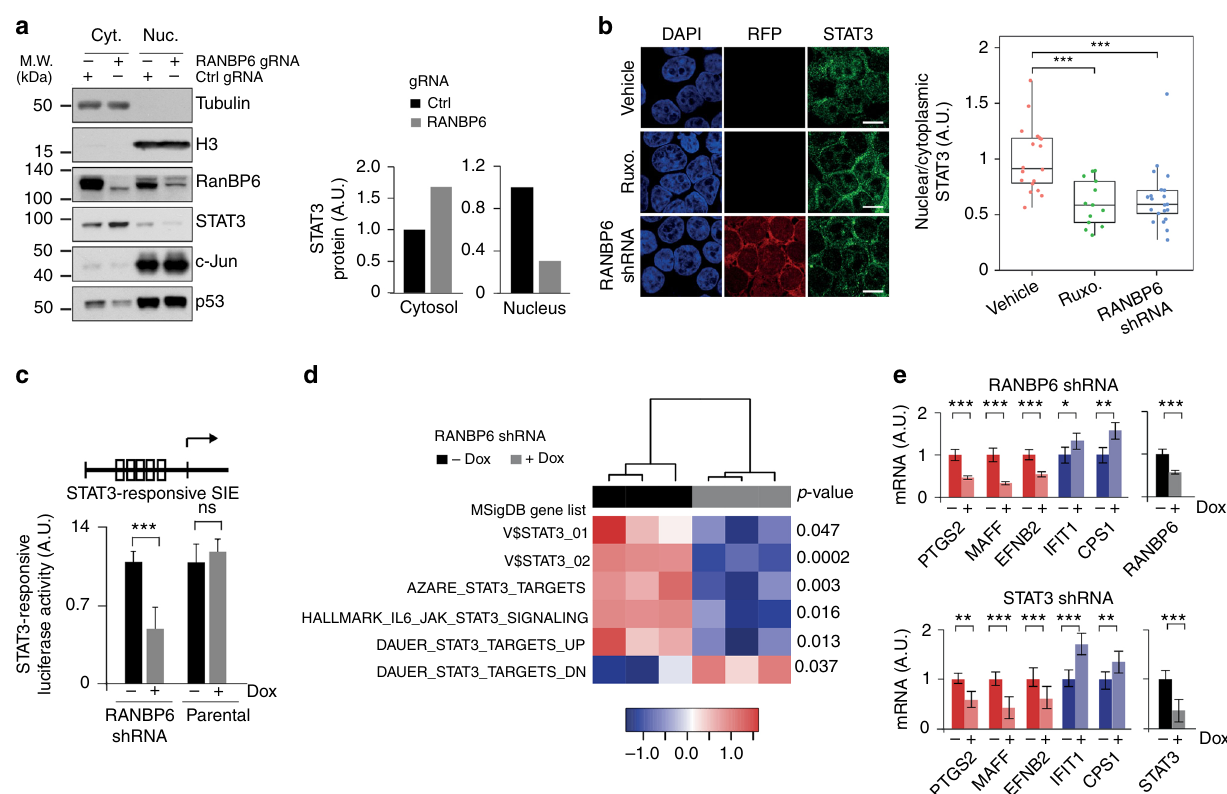
Fig. 3 RanBP6 promotes nuclear translocation of STAT3. a RanBP6 knockout (KO) increases cytoplasmic STAT3 and lowers nuclear STAT3. Left panel, immunoblots of cytoplasmic (Cyt.) and nuclear (Nuc.) cell fractions; right panel, densitometry of STAT3 immunoblots. b RanBP6 KD impairs IL-6-induced nuclear STAT3 translocation. Left panel, confocal immuno fl uorescence. RFP is used as a reporter for shRNA expression. Right panel, ratios of nuclear/ cytoplasmic STAT3 staining ( fi eld of views: vehicle, n = 18; ruxolitinib, n = 13; RANBP6-shRNA, n = 21). The janus kinase (JAK) inhibitor ruxolitinib was included as a positive control. Scale bar = 10 μ m. c RanBP6 KD decreases transcription of STAT3 reporter gene. SIE sis-inducible elements. d Gene expression pro fi ling showing the effect of RanBP6 KD on endogenous STAT3 target genes. Heatmap represents the enrichment scores from single-sample gene set enrichment analysis (ssGSEA) of three biological replicates. Student ’ s t test p -values (Dox − vs. Dox+) for each gene sets are indicated. e Quantitative PCR analysis of the expression of some RanBP6-regulated genes selected from ssGSEA (top panel) con fi rmed to be regulated by STAT3 (bottom panel). Data are represented as mean ± SD ( n ≥ 3). Student ’ s t test: *** p < 0.001; ** p < 0.01; ns not signi fi